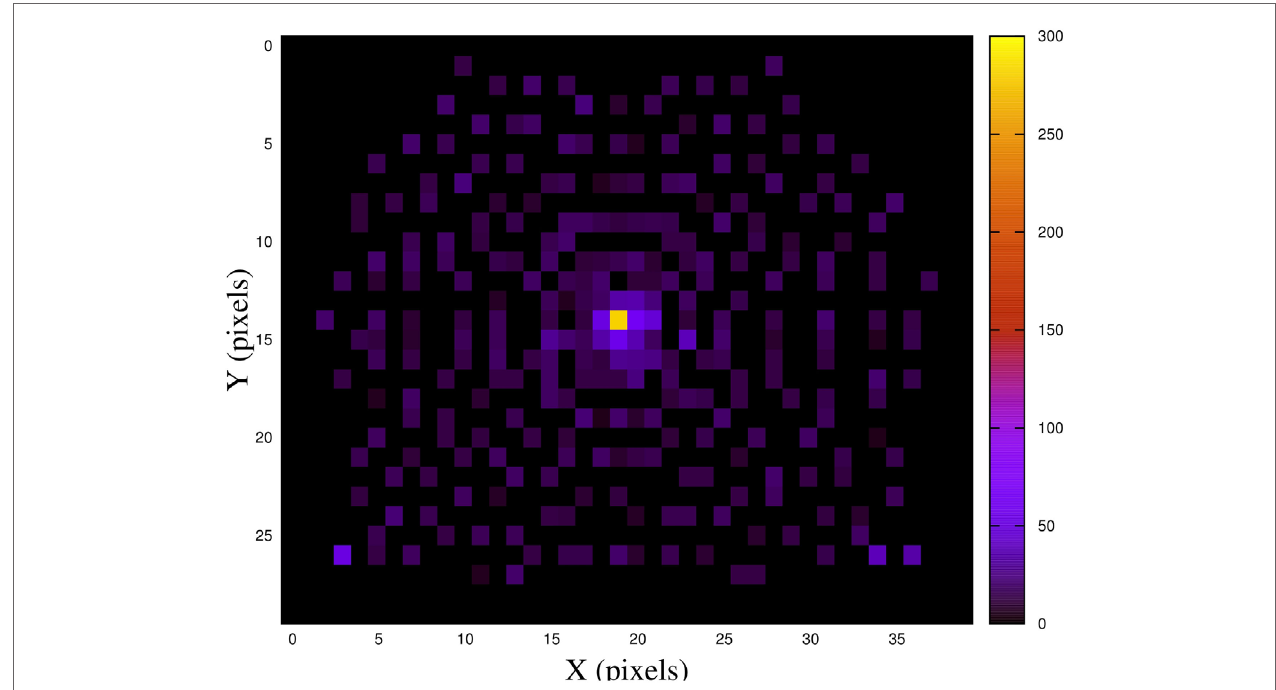
FigUre 6 | Visual stimulus distribution on different positions of the camera